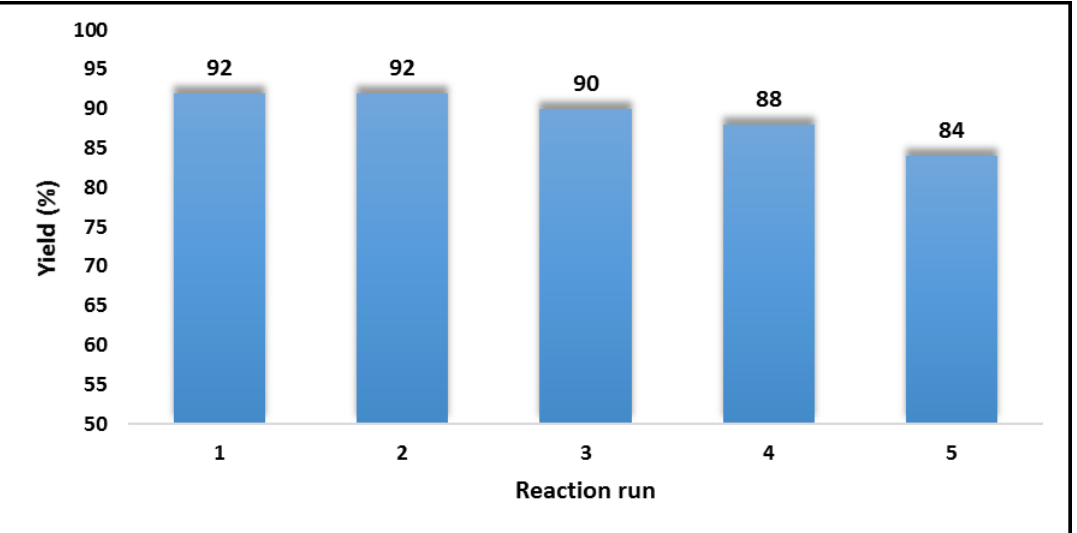
Figure 8. Recyclability of Ag@CDNS-N/PMelamine for the synthesis of model reaction.